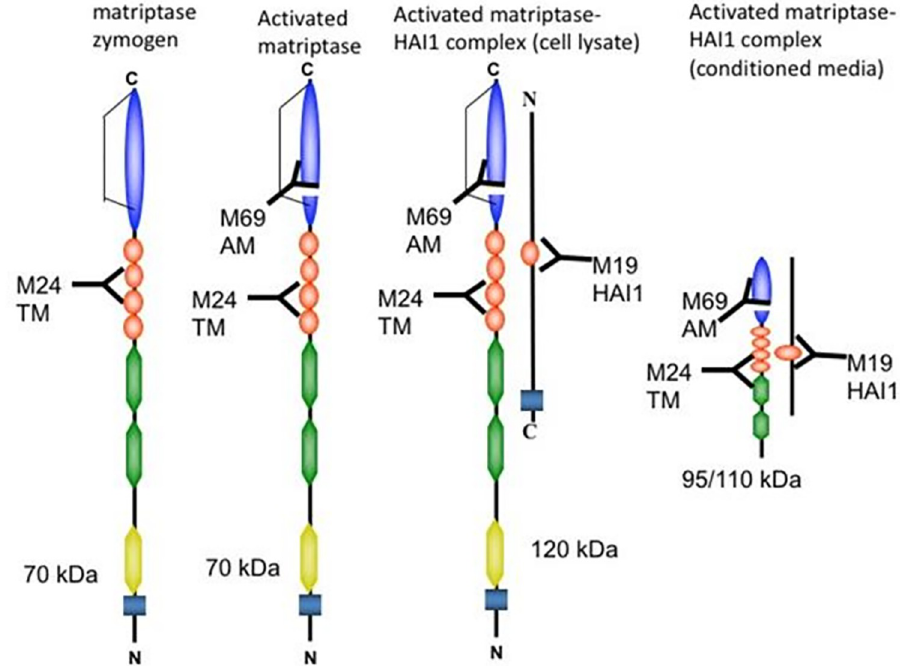
Fig 1. Matriptase expression and activation